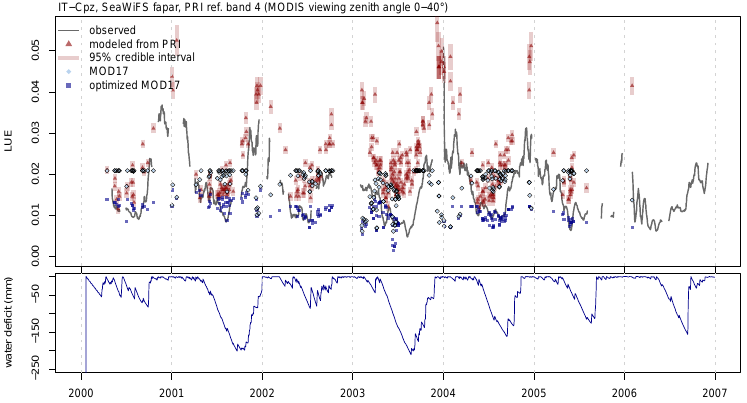
Fig. 7. Top: Time series of observed LUE as 14-day moving average (based on SeaWiFS faPAR) and modelled LUEs (exponential model based on PRI with reference band 4, MOD17, and optimised MOD17) at the IT-Cpz site. Bottom: Water deficit in mm (calculated from water